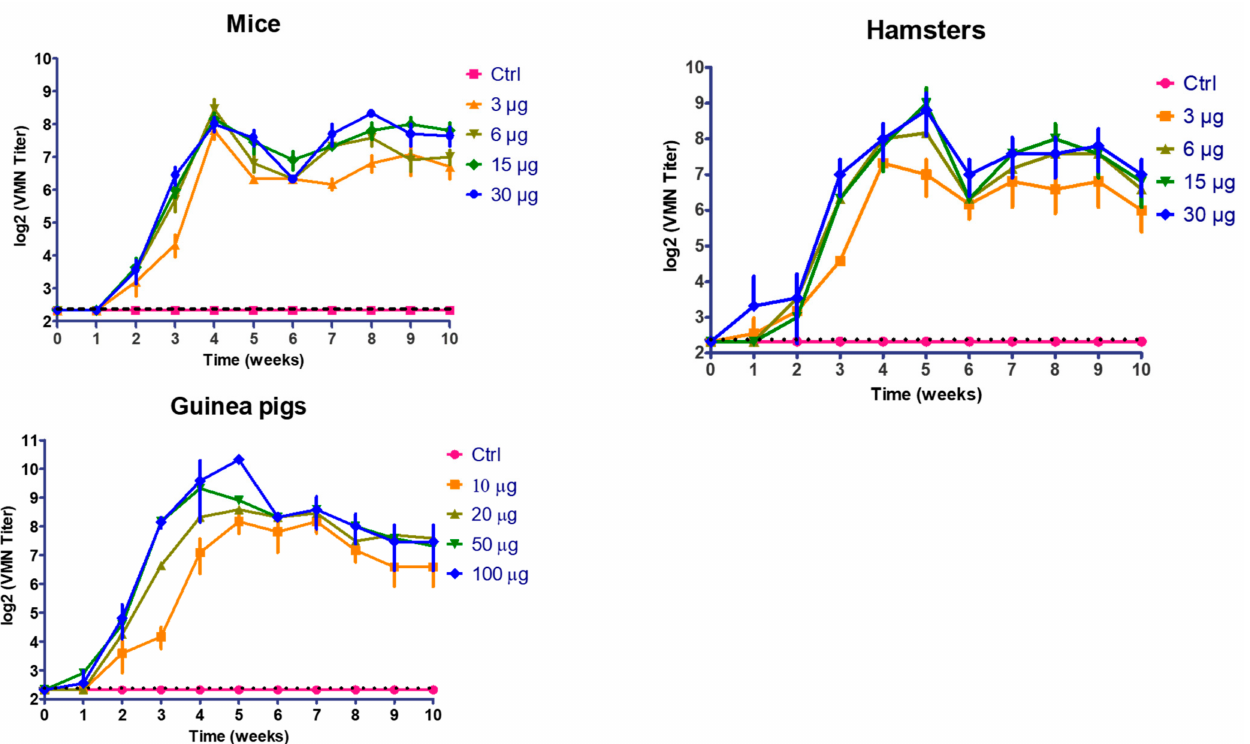
Figure 2. Follow up of virus microneutralization (VMN) antibody titers in vaccinated mice, hamsters, and guinea pigs using different vaccine doses. (Ctrl: